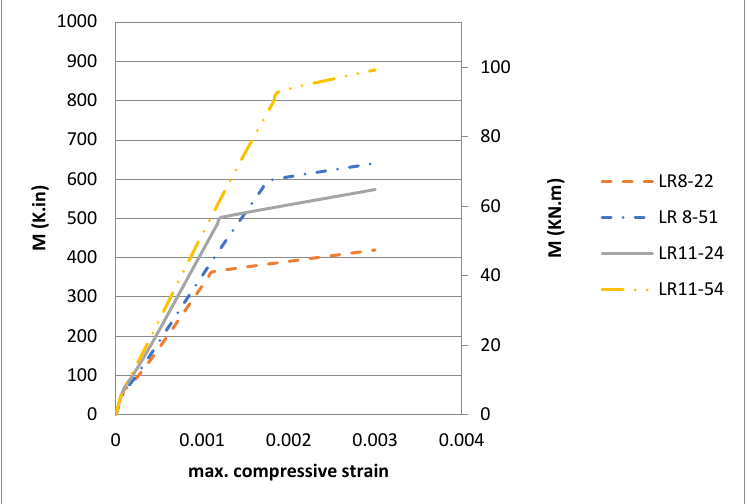
Figure 13. Ahmad and Barker (1991) [16] moment vs. curvature analytical graphs.